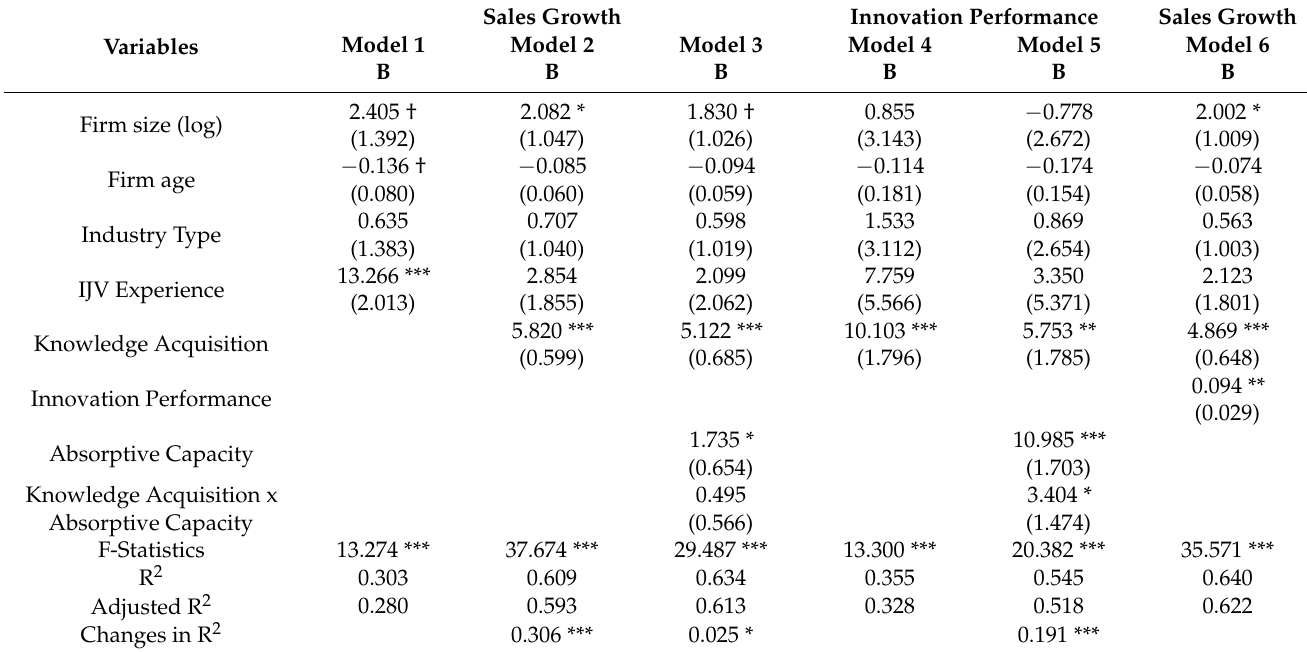
Table 2. Hierarchical multiple regression for sales growth and innovation performance ( n = 127).